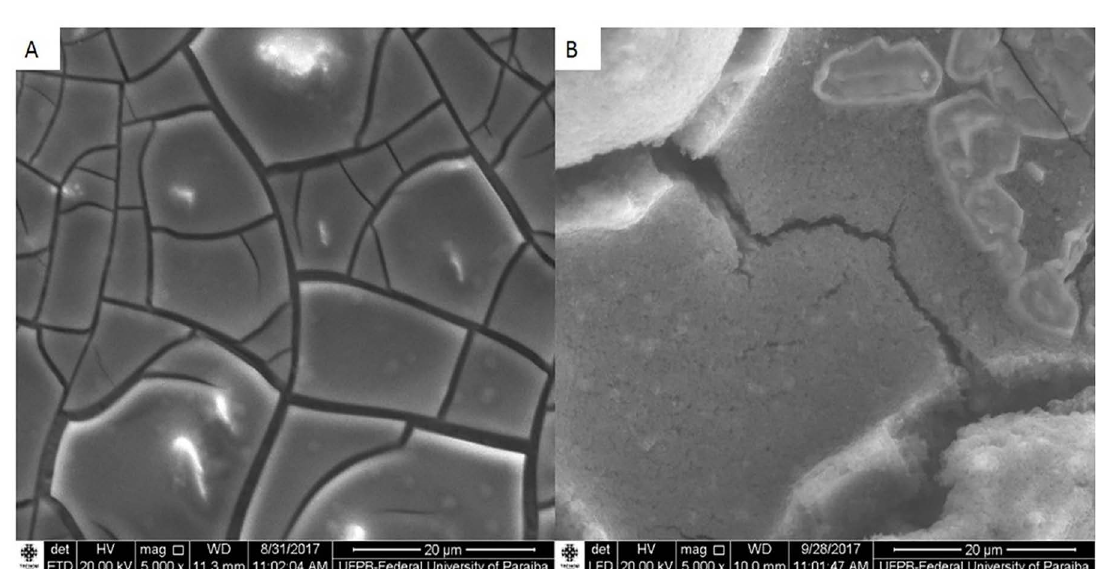
Figure 7. Micrographs of the sample 1 without (a) and with (b) the AR